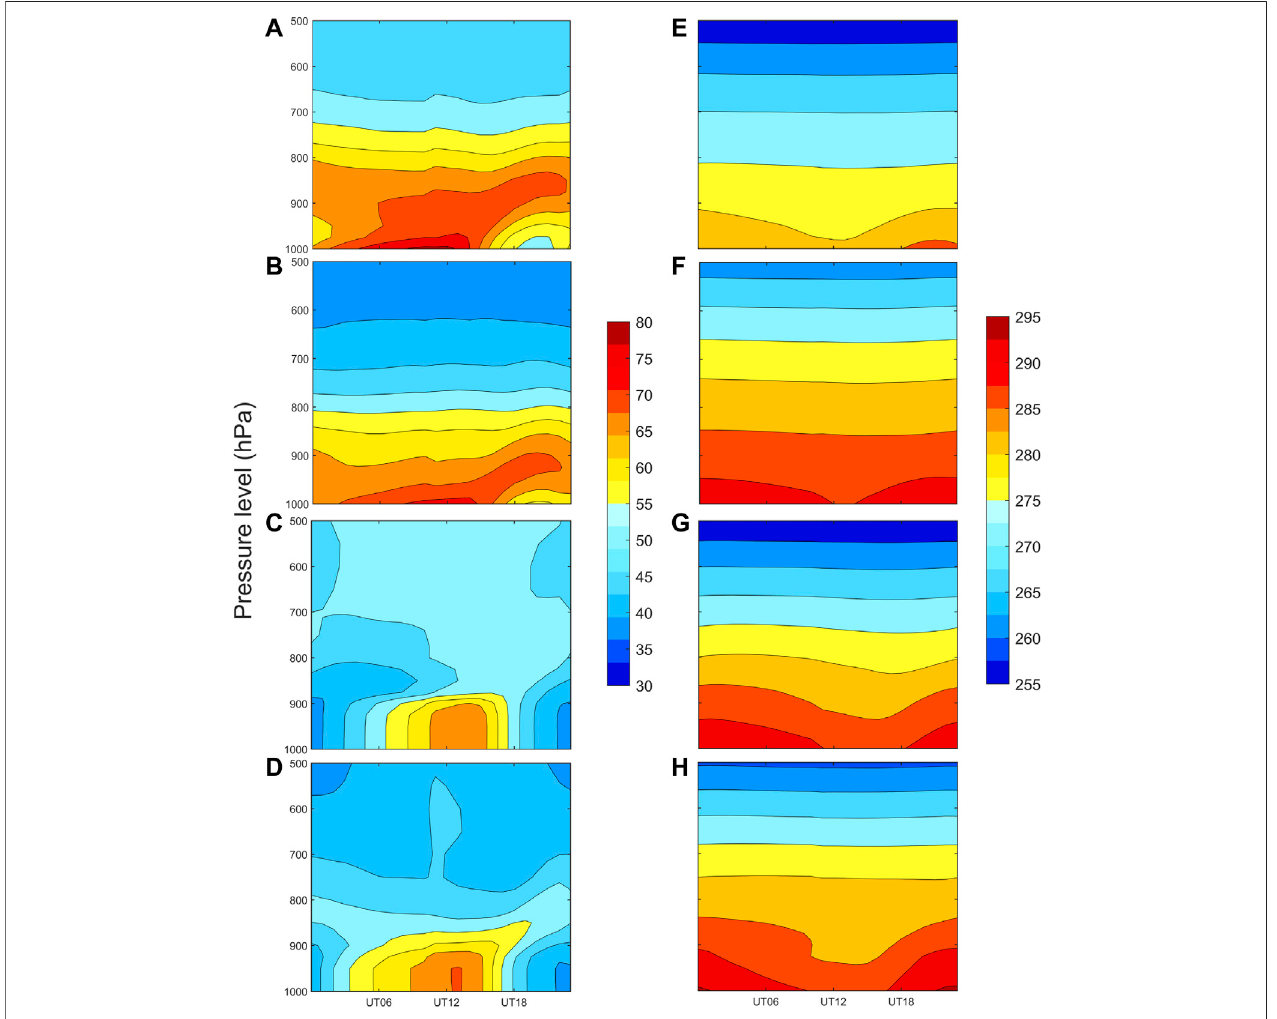
FIGURE 4 | Variation of relative humidity (A – D) (unit: %) and temperature (E – H) (unit: K) with altitude and hours in a day. The distribution of fi gures is the same as that in Figure 3 .